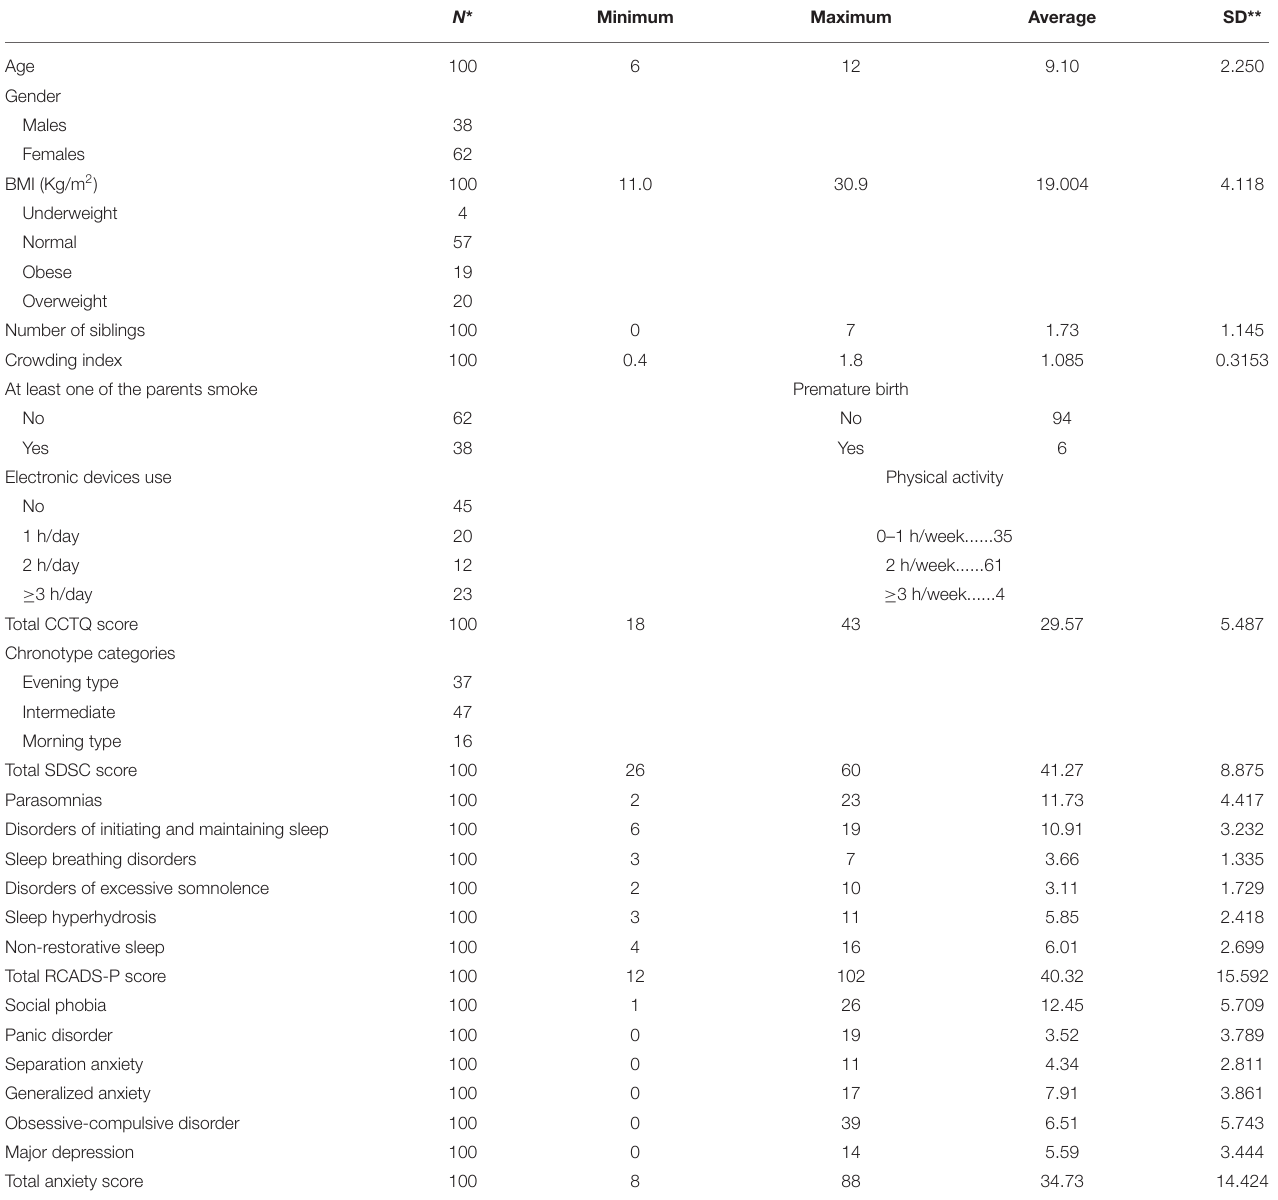
TABLE 1 | Socio-demographic characteristics, eating patterns, physical activity, and electronic devices use of the participants and results obtained for the questionnaires of SDSC, CCTQ, and RCADS-P. N *